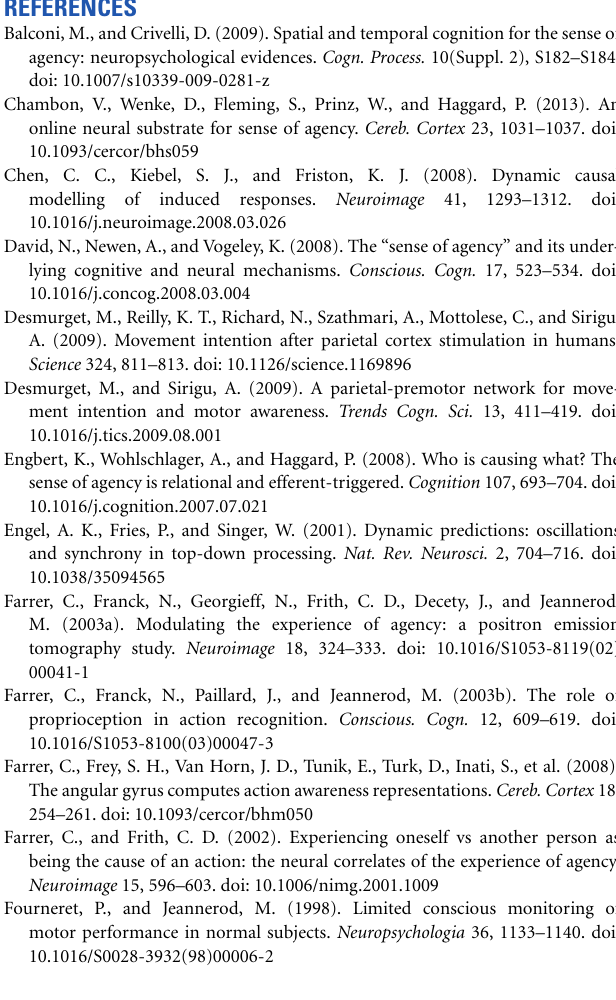
Supplementary Figure S1 | Time-frequency plots observed and predicted from DCM. Comparison of time-frequency plots of the observed two source regions (preSMA and IPC) for the (A) early and (B) late task phases for AgencyYES and AgencyNO trials with the predictions made by the DCMs (model 8 early and model 6 late). Notice for one participant (shaded) no dynamics were predicted by any of the 9 DCMs (here only model 6 is displayed) for the late task